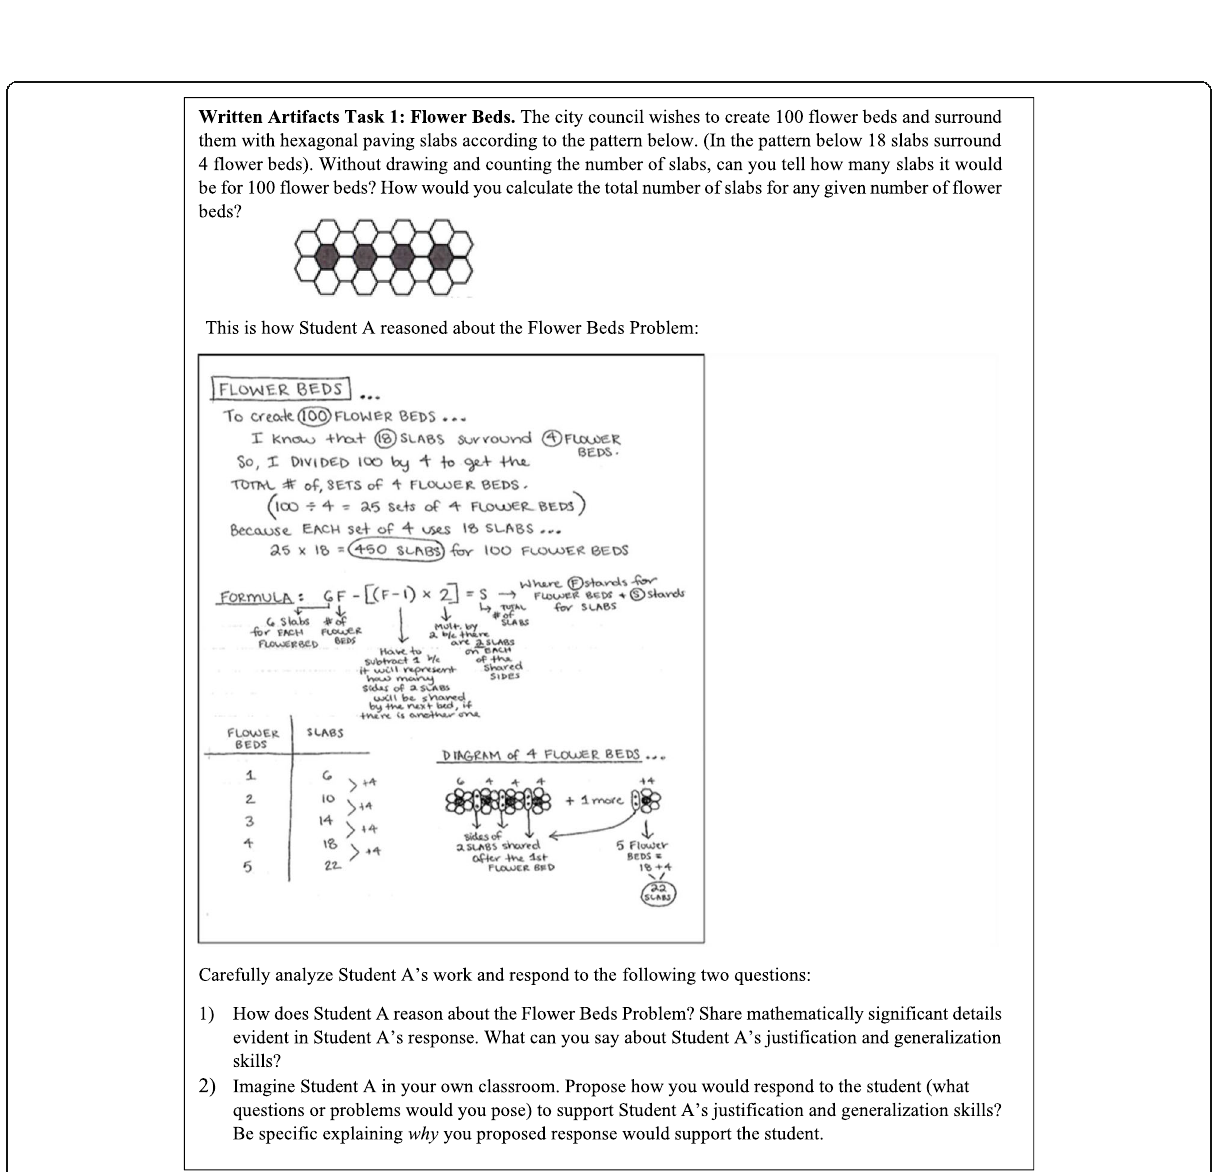
Fig. 3 Written artifacts task 1 (student work from Magiera, van den Kieboom, & Moyer,